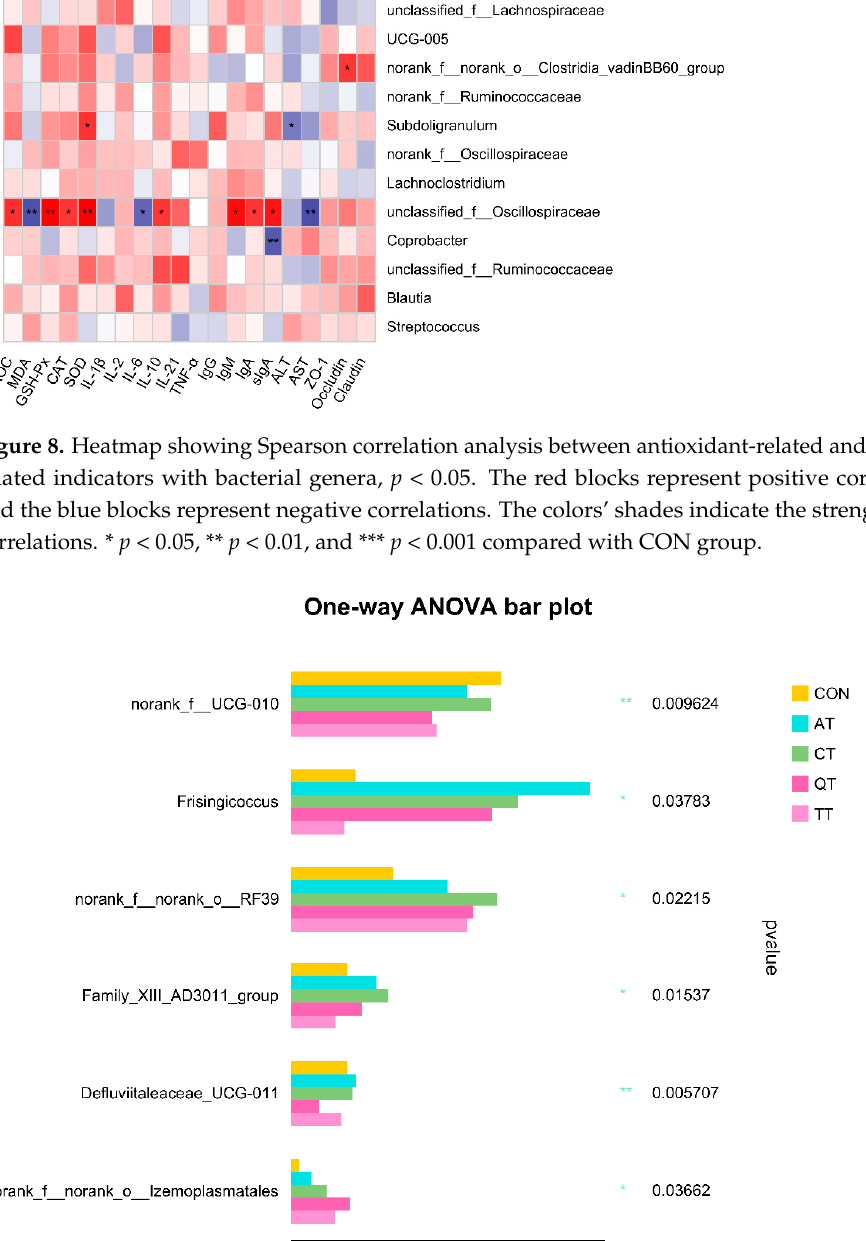
Figure 9. Significant test of group differences based on one-way ANOVA test. The right of the bar is the p -value; * p < 0.05, ** p < 0.01. CON, control; AT, Acacia mearnsii tannin; CT, Castanea sativa tannin; QT, Schinopsis lorenzii tannin; TT, Caesalpinia spinosa tannin.